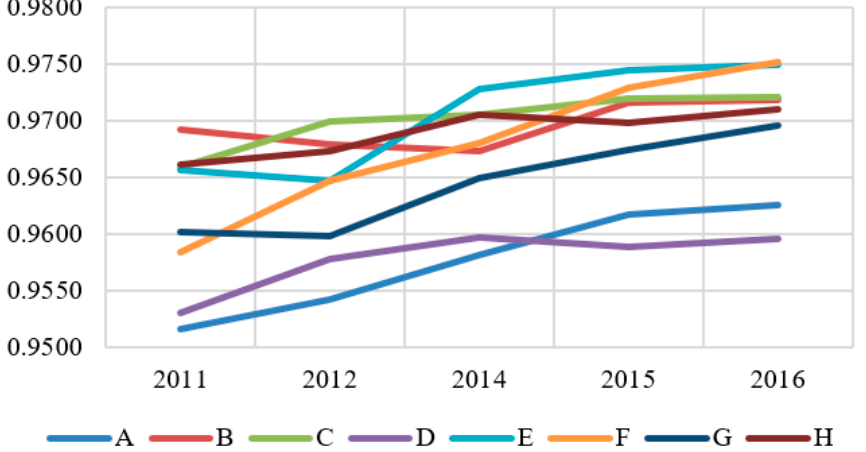
Figure 5. The average value of the using roadworthy vehicles rate for the analysed road freight transport enterprises in the years 2011–2016.